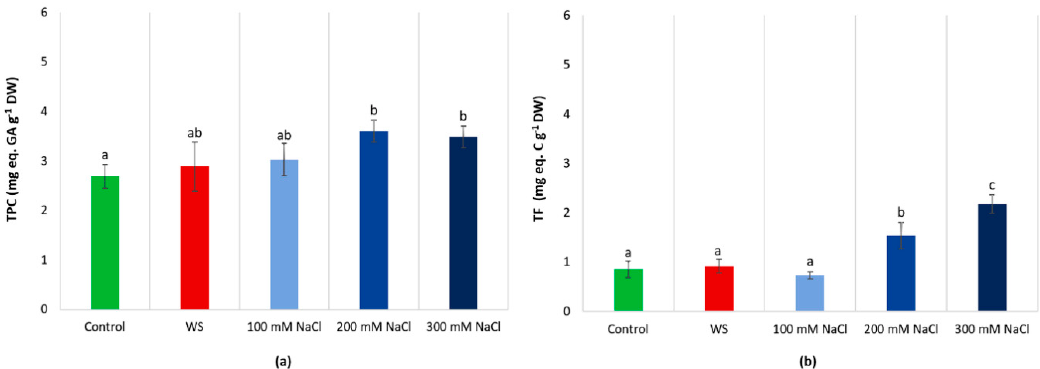
Figure 7. ( a ) Total phenolic compounds (TPC) and ( b ) total flavonoids (TF) needle contents in one-year-old A. alba seedlings after 30 days of growth in the presence of the indicated NaCl concentrations or subjected to water deficit stress (WS). Bars represent means ± SE ( n = 7). Different letters above the bars indicate significant differences between treatments, according to Tukey’s test ( α = 0.05).